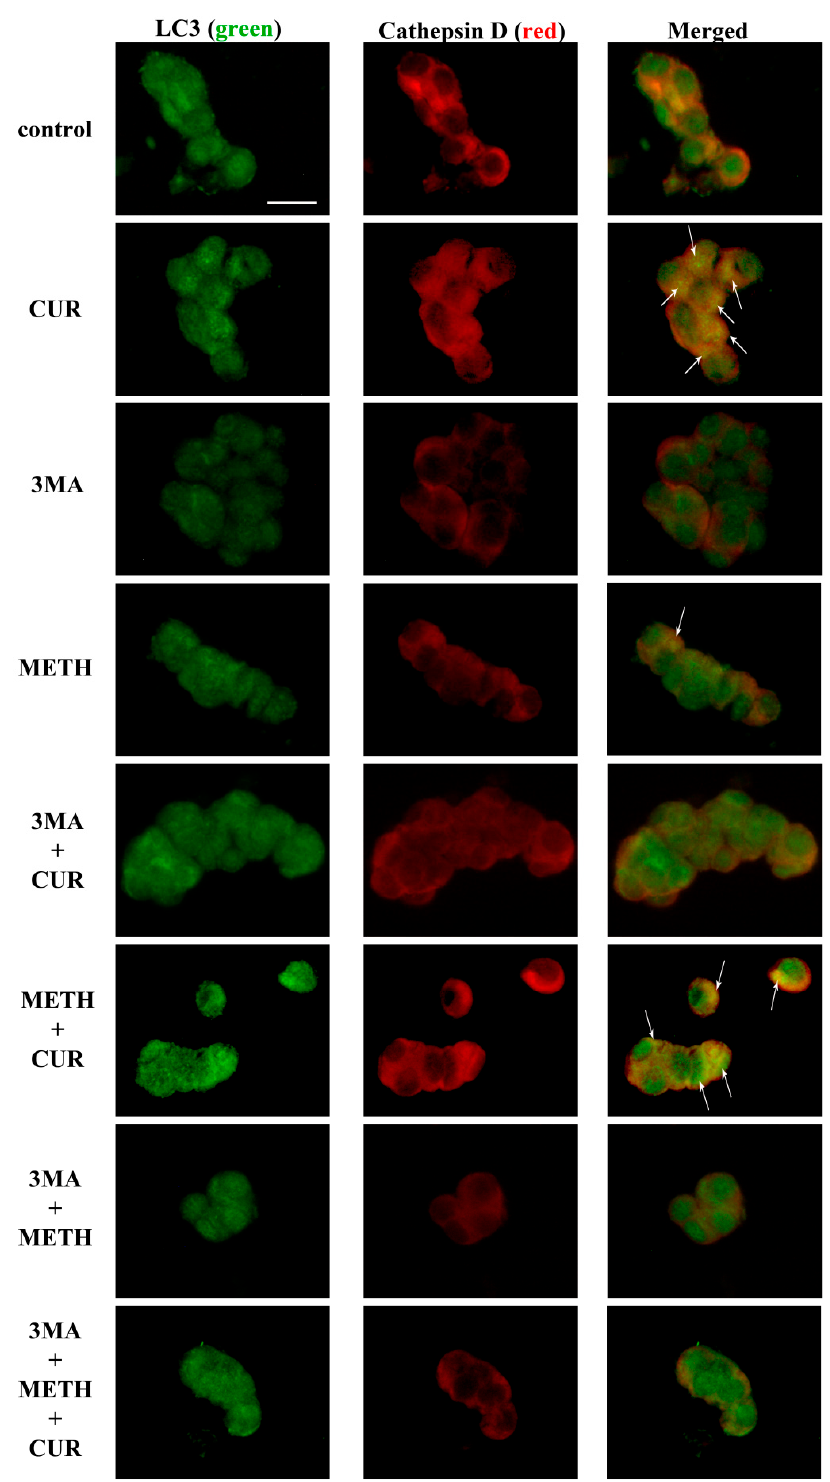
Figure 21. CUR increases, while 3MA reduces, LC3 and cathepsin D co-localization . Representative pictures showing double immunofluorescence for LC3 (green) and cathepsin D (red), and their merge. PC12 cells were treated for 72 h with CUR 10 μ M, METH 100 μ M, and the autophagy inhibitor 3MA. Arrows indicate cells with intensely merged fluorescence resulting in yellow puncta. Scale bar = 11.4 μ M.